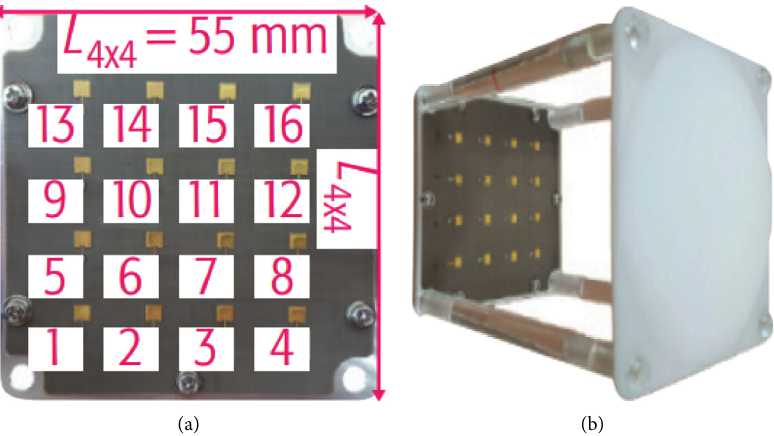
Figure 11: Patch array (a) and lens antenna array prototype (b) proposed in [75] ©2018 IEEE.